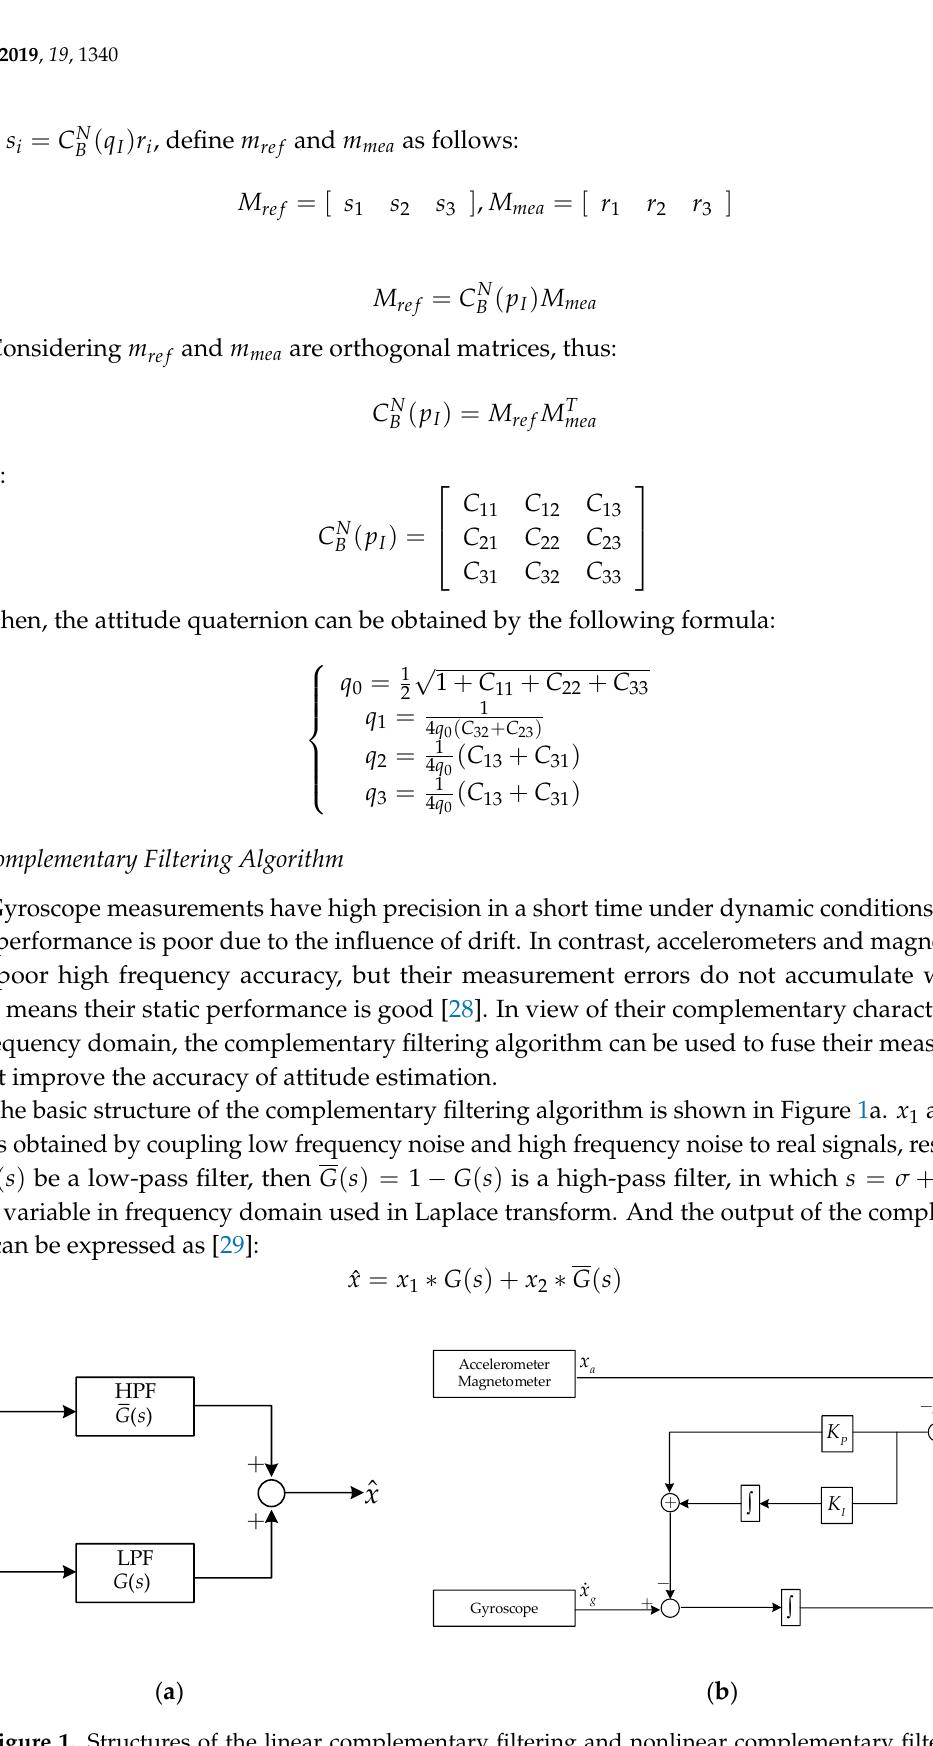
Figure 1. Structures of the linear complementary filtering and nonlinear complementary filtering: ( a ) Structure of CF; ( b ) structure of NCF.